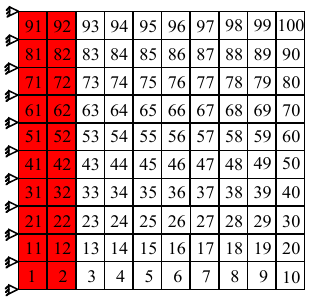
Figure 7. The modal strain energy distribution of the first five orders of cantilever thin plate: ( a ) The first order; ( b ) the second order; ( c ) the third order; ( d ) the forth order; ( e ) the fifth order.